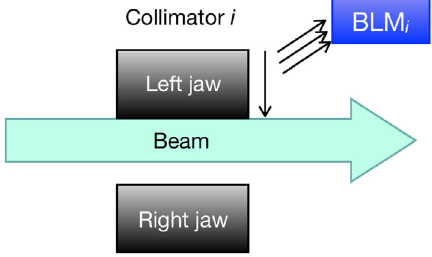
FIG. 2. The jaws of collimator i around the beam, with its left jaw scraping the beam halo, and the showers are detected by the corresponding BLM detector